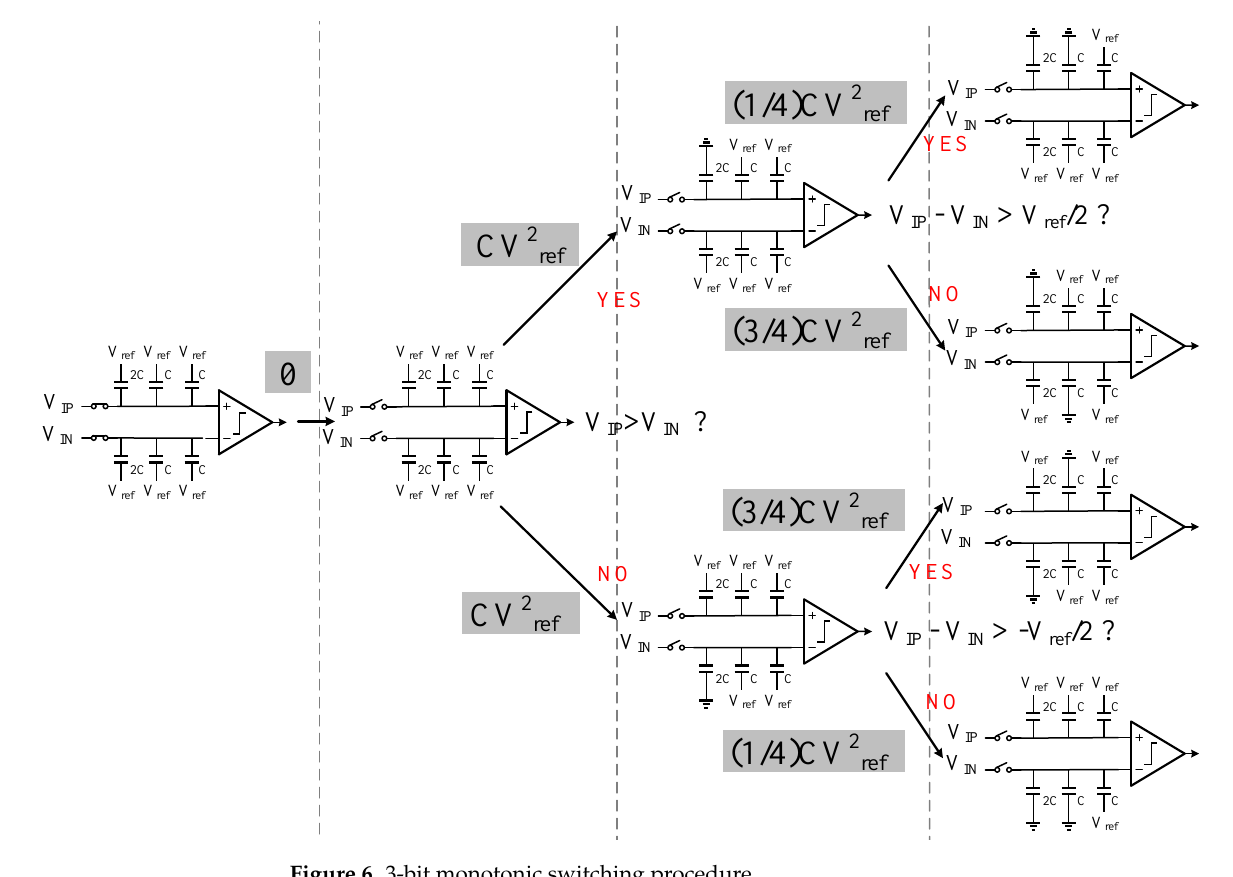
Figure 6. 3-bit monotonic switching procedure.